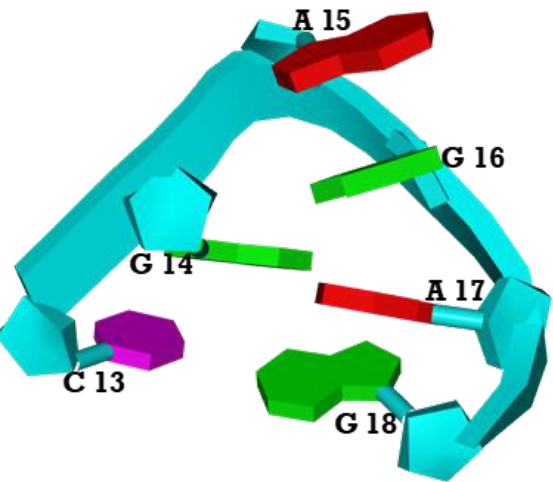
Figure 1. Ligand structure (CGAGAG) used in molecular docking. The hydrolysis of the adenine base of A15 in the loop region is catalyzed by the A-chain of type 2 RIPs.